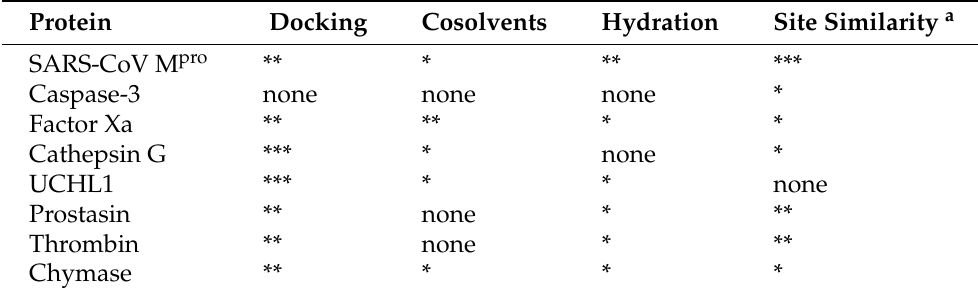
Table 3. Conclusions for selectivity of SARS-CoV-2 M pro